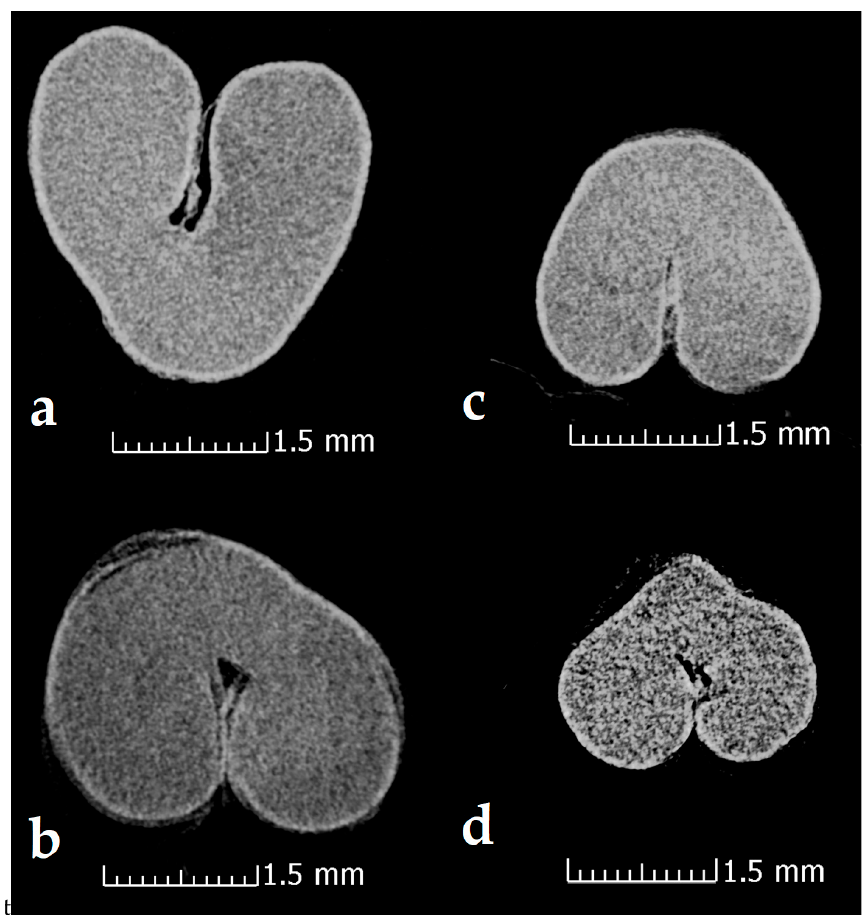
Figure 5. CT image images of control wheat seeds ( a , b ) (‘Dacic’/’Otilia’) and plasma-treated seeds ( c , d ) (‘Dacic’/’Otilia’).